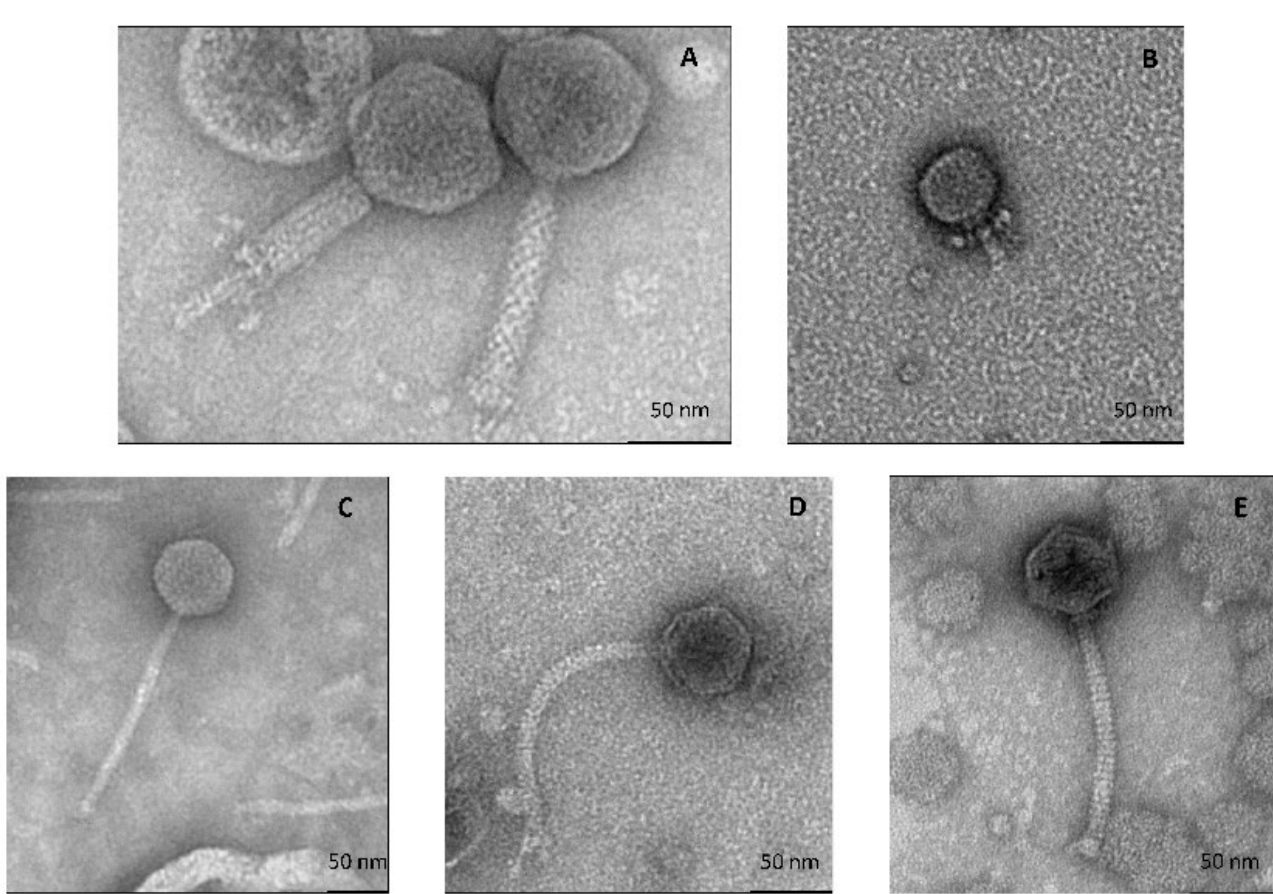
Figure 1. Transmission electron micrographs of 5 phages isolated from cheese rind. ( A ), Psychrobacter phage D’Alembert (contracted form at left), ( B ) Glutamicibacter phage Voltaire, ( C ) Glutamicibacter phage Montesquieu, ( D ) Brevibacterium phage Rousseau and ( E ) Leuconostoc phage Diderot.